Question: According to the figure, is the described quantity increasing or decreasing?
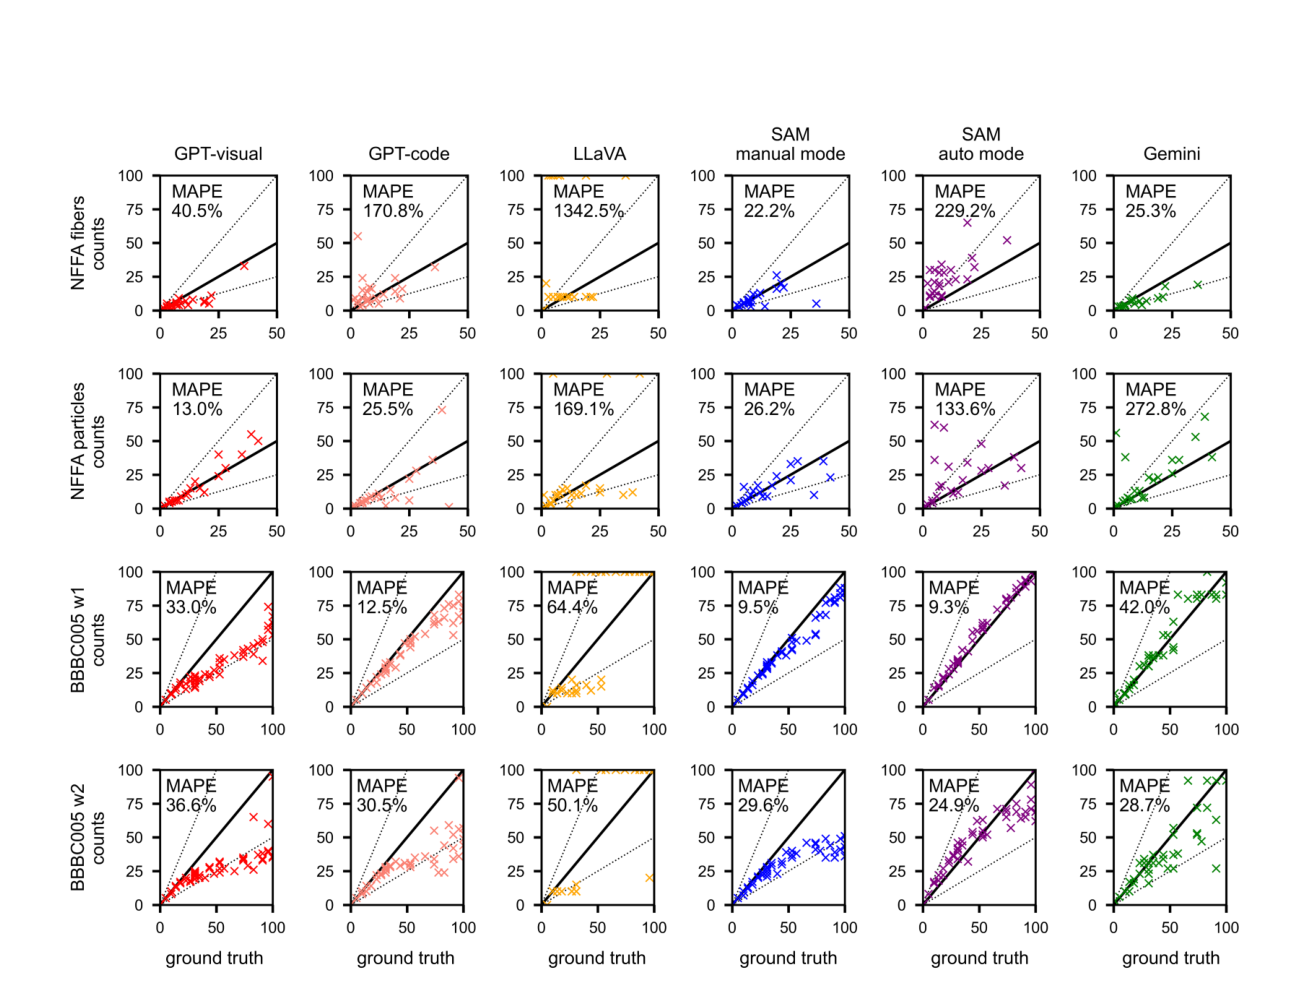
Answer: increasing